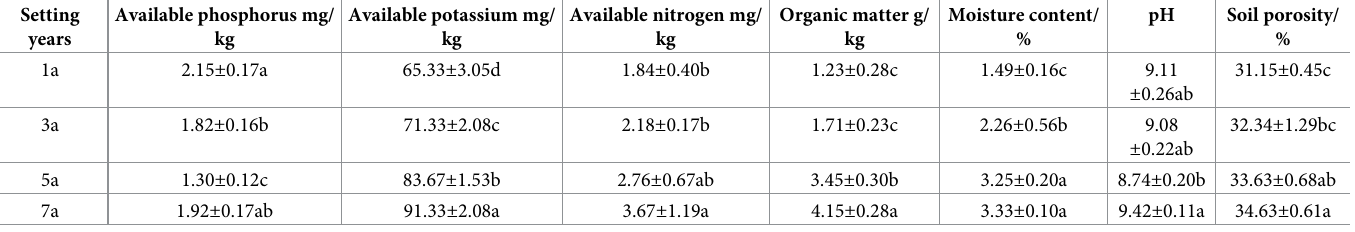
Table 1. Differences in soil physicochemical properties under different setting years of S . psammophila sand barriers. Setting Available phosphorus mg/ years